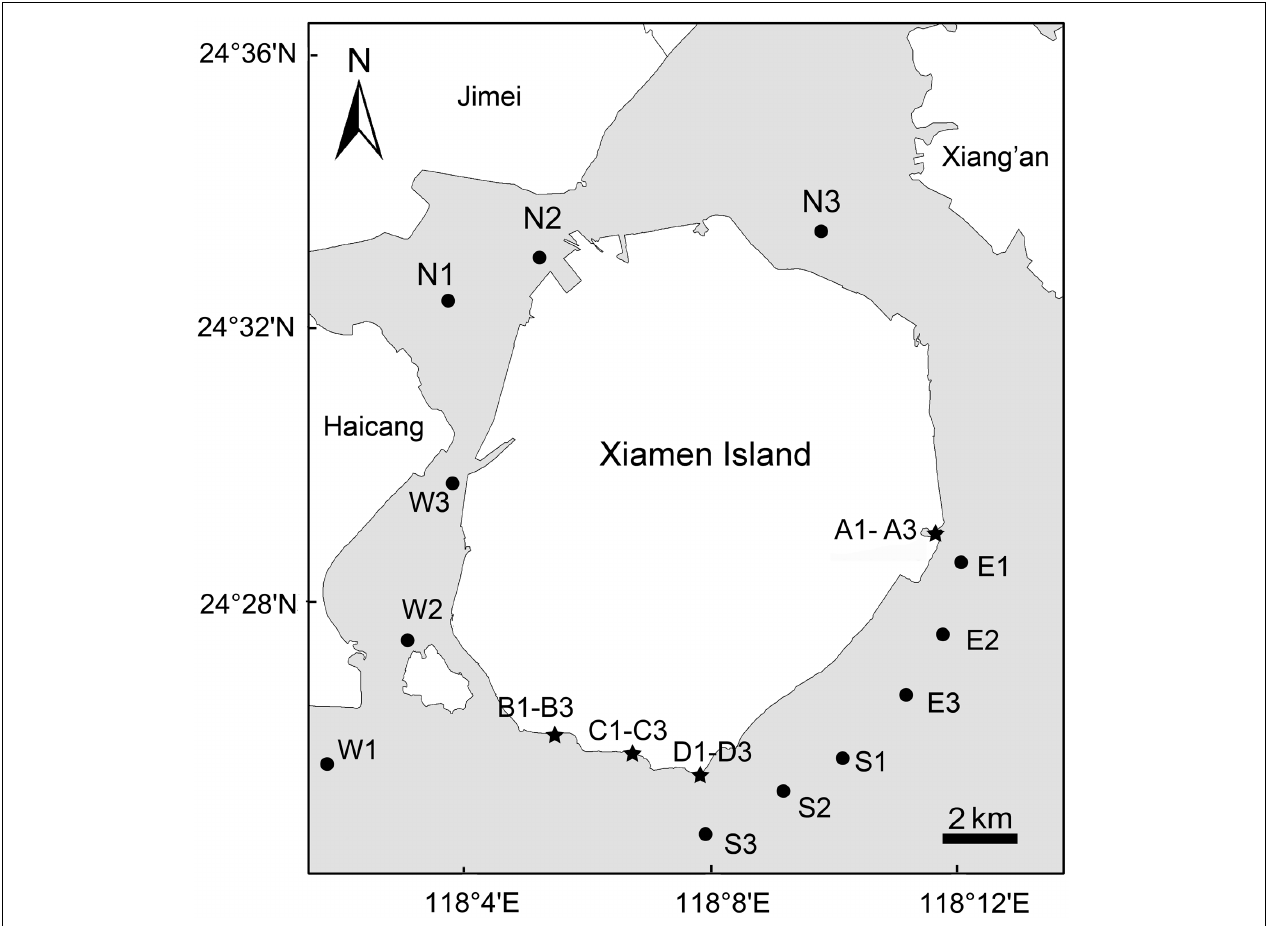
FIGURE 1 | Sketch map of Xiamen island showing the 24 sampling sites in offshore sea water (dots) and sandy beach sediment (stars). A total of 24 samples including 12 surface seawater samples ( < 0.5 m depth) and 12 surface sediment samples (0–5 cm depth) were collected from Xiamen coastal waters and intertidal sandy beaches in late July 2013 and early September 2014, respectively. The map of Xiamen Island with sampling sites was constructed using ArcGIS